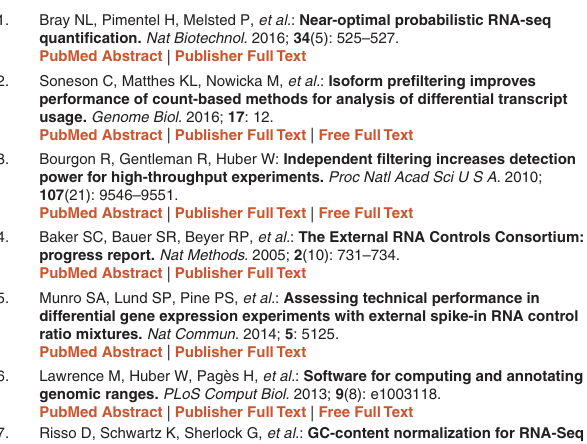
Supplementary Figure S2: Arkas-Quantification output directory. A ) Depicts the Arkas-Quantification output directory which includes sample folders containing Kallisto data. B ) Depicts the contents of a specific folder output by Arkas-Quantification . Click here to access the